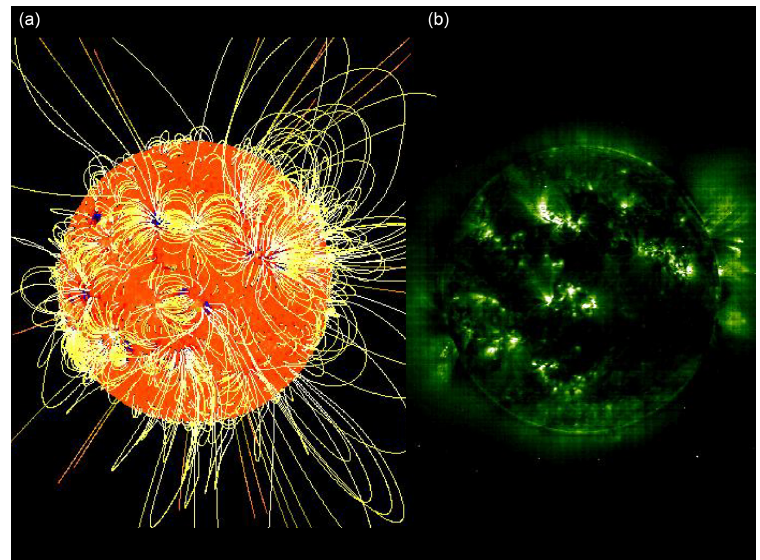
Figure 3. (a) Solar magnetic field constructed from potential-field extrapolation of the surface magnetic field after Wiegelmann and Solanki (2004); (b) image of the corona taken by the SOHO extreme ultraviolet imaging telescope in the emission line Fe XII 19.5nm of iron. Note the coincidence of bright regions with closed magnetic field loops and dark areas with open magnetic field lines. Magnetically active regions mainly consist of closed loops in which plasma can be confined and cause bright emission. Yet the large-scale magnetic field is open in coronal holes, from which plasma can escape on open field lines as solar wind, and where the electron density, and thus the emission, is strongly